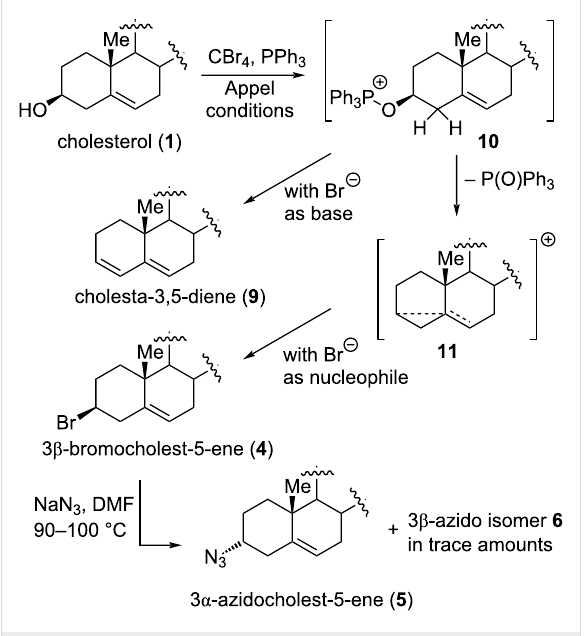
figuration locating the azido substituent on the β -face of the steroid (compound 6